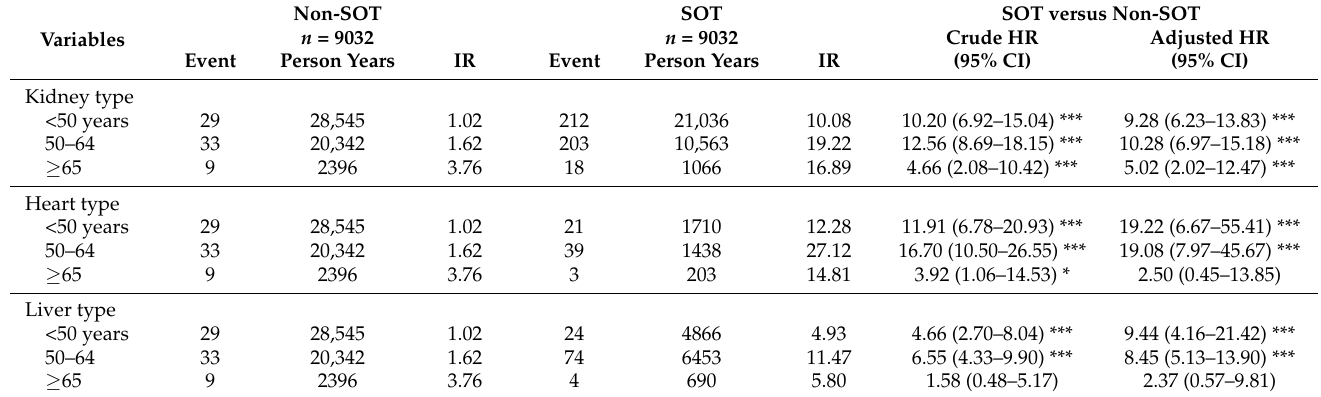
Table 3. aHV infection risk in subgroups of organs by stratification of age.